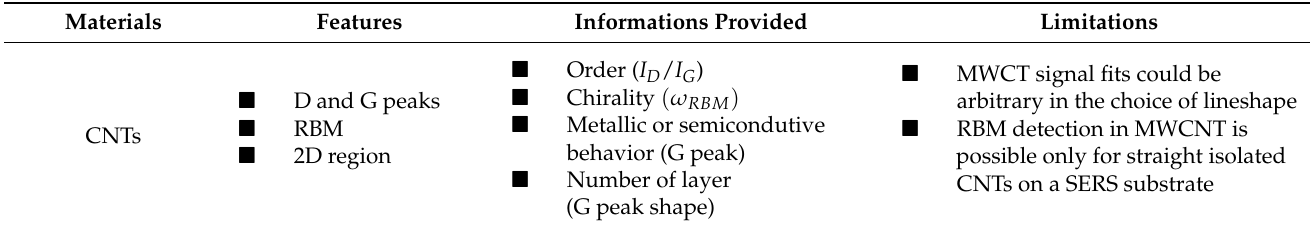
Table 1. Overview of the data achievable for each of the main classes of materials analyzed though Raman spectroscopy.